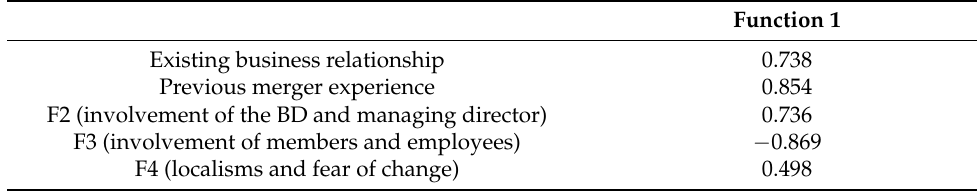
Table 8. Standardised coefficients of the derived discriminant